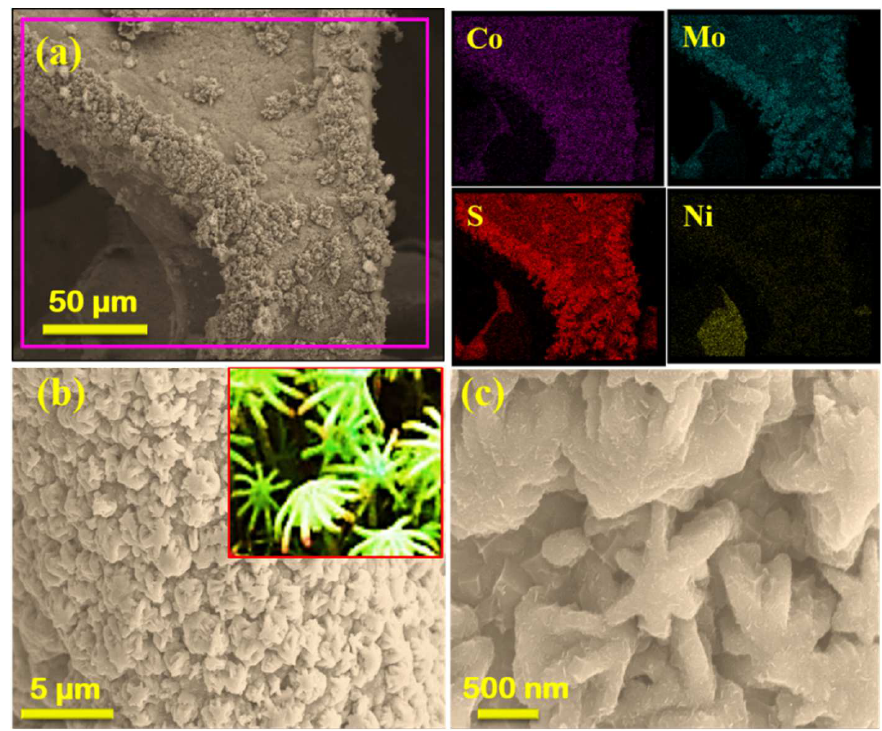
Figure 2. SEM images of NCMS at different magnifications ( a – c ) and the elemental mapping of ( a ) for Co, Mo, S, and Ni. The inset in ( b ) is a picture of female sporocarps, similar to the morphology of NCMS in ( c ).